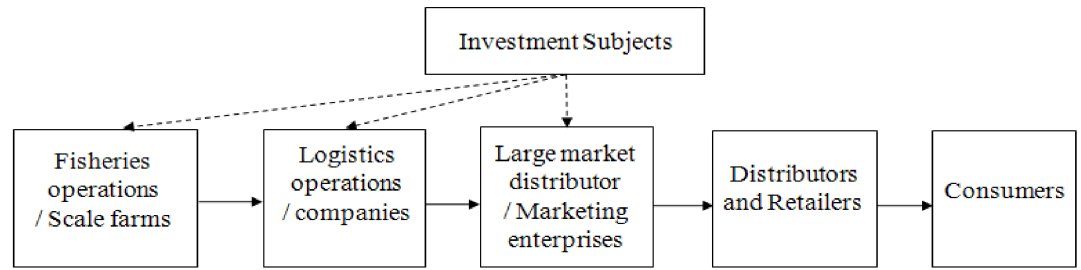
Figure 3. Subjects relationship of Compact